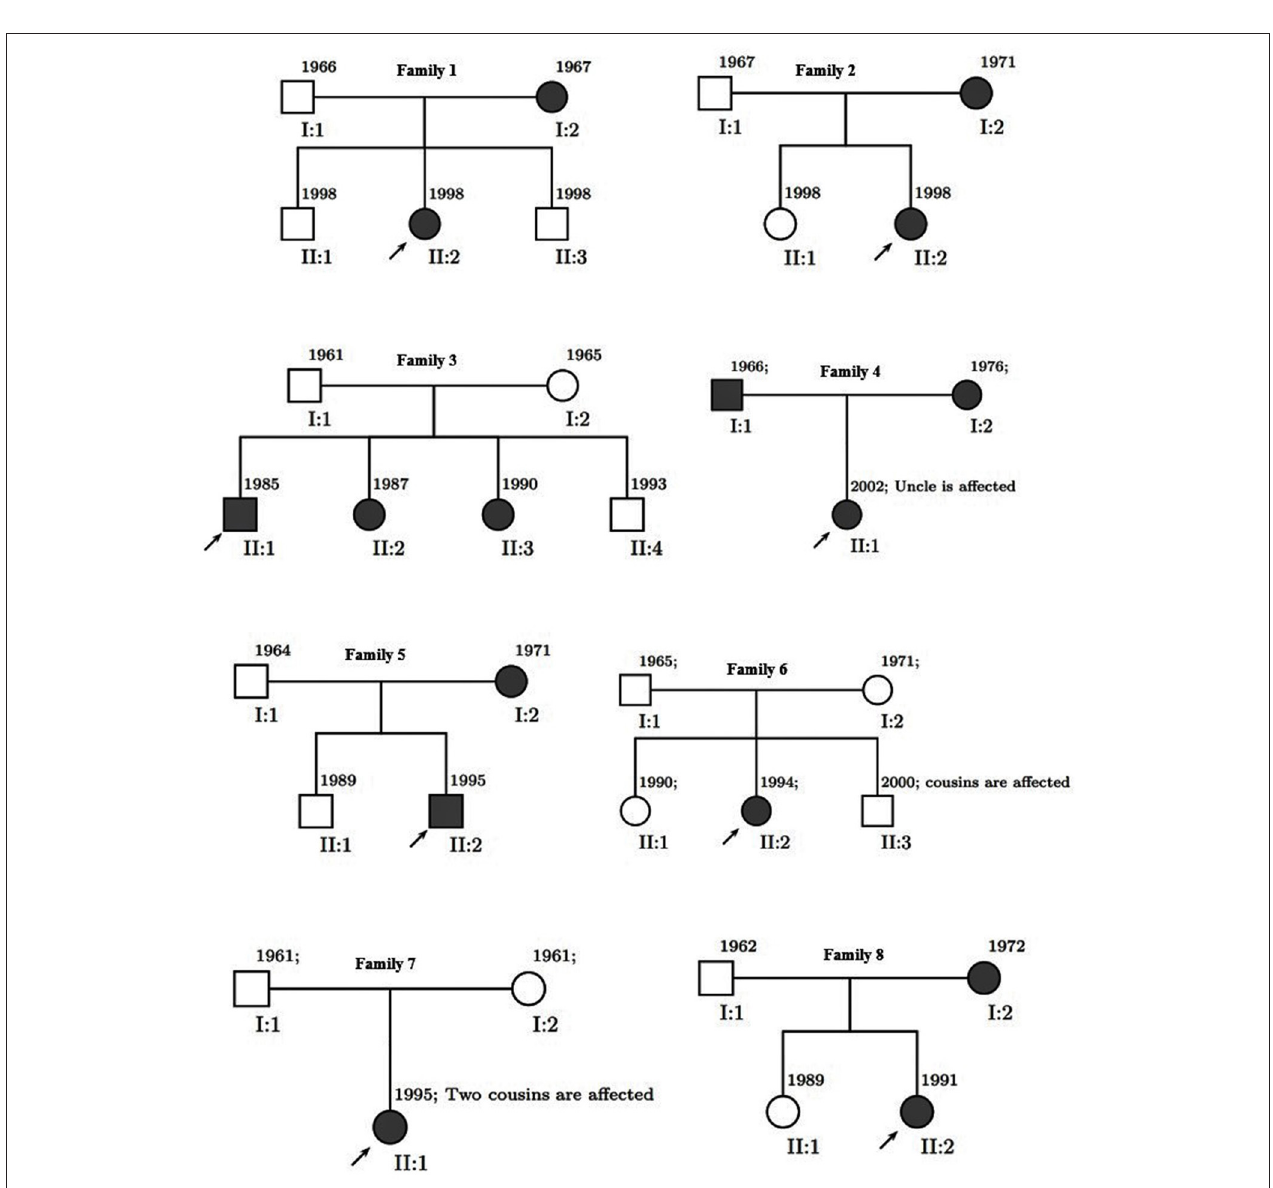
FIGURE 2 | Pedigree of eight families. Men are represented by squares and women by circles. Solid square (male) or circle (female) represent an individual with multiple sclerosis.